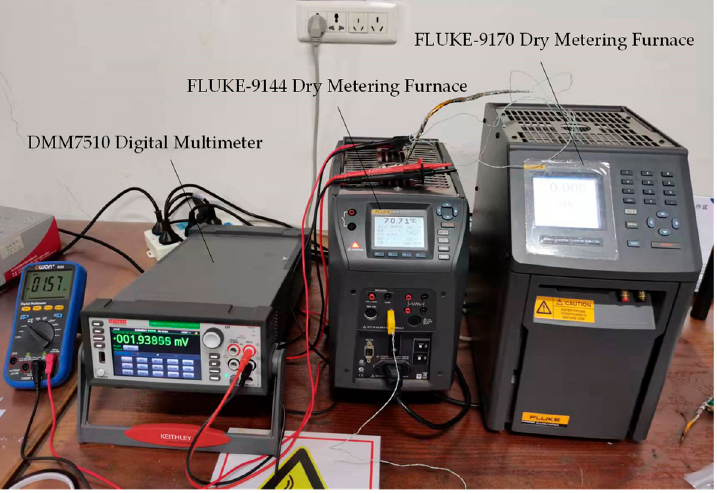
Figure 10. A thin film thermocouple temperature sensor static calibration system.